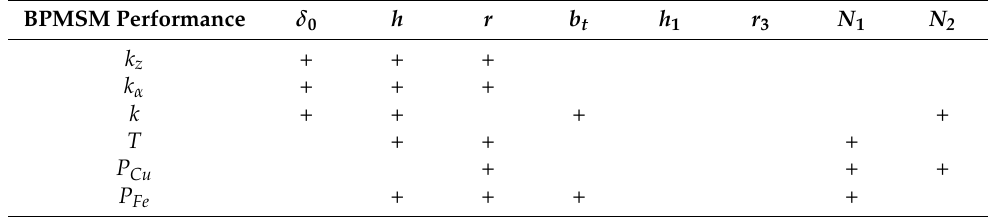
Table 2. Sensitivity evaluation